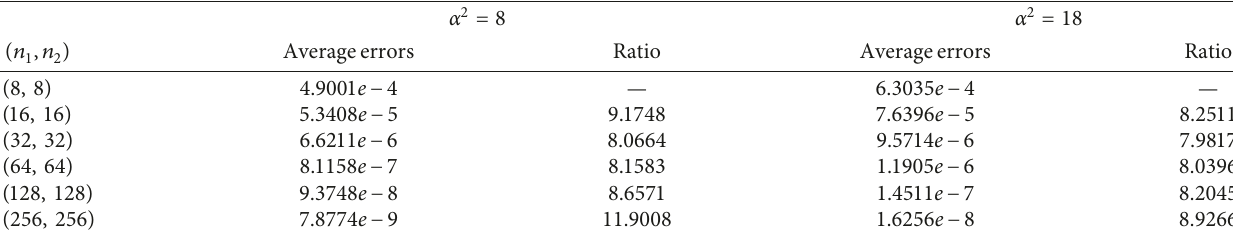
Table 4: The simulation results for Example